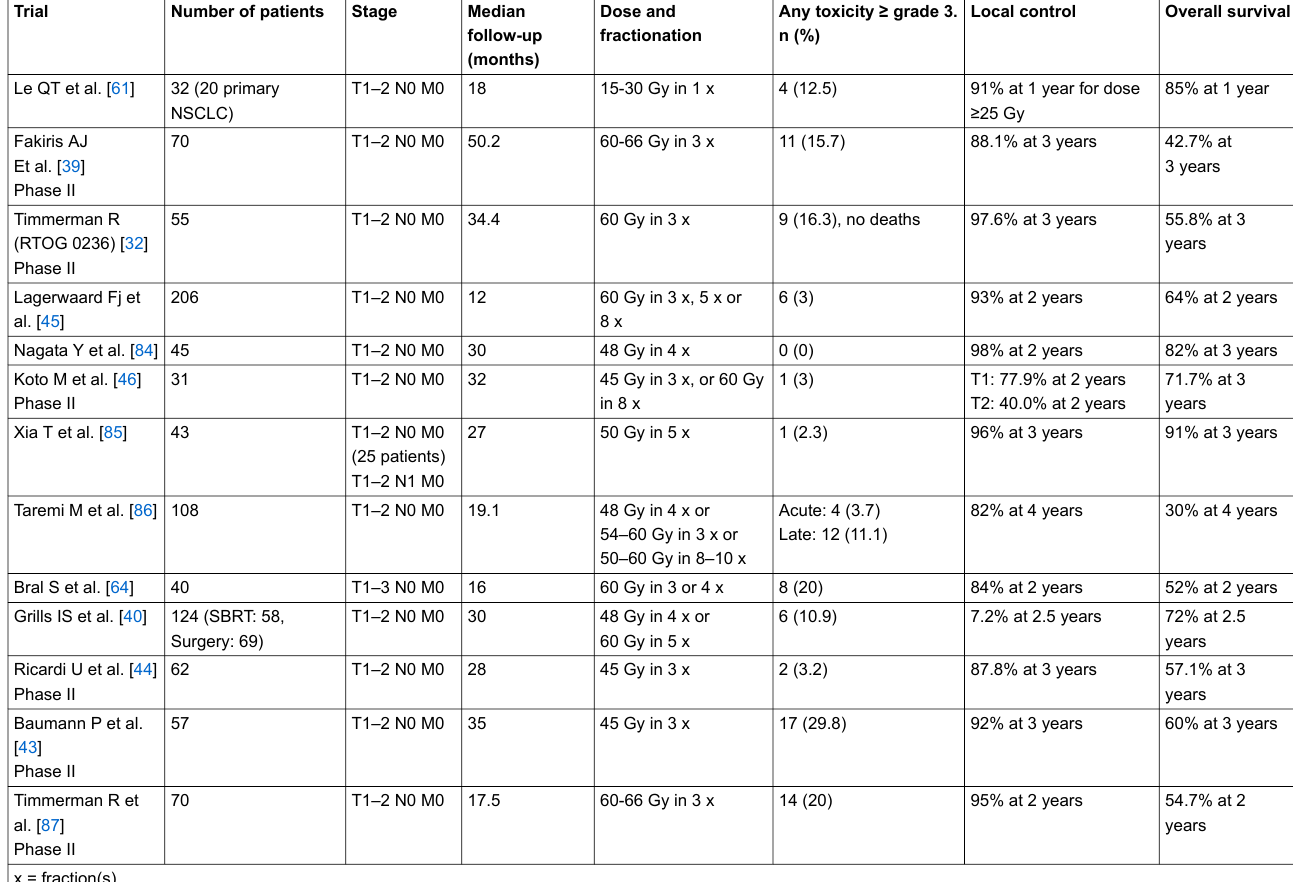
Table 2: Summary of the results of the prospective trials of stereotactic ablative radiotherapy for early stage non-small cell lung cancer. Trial Number of